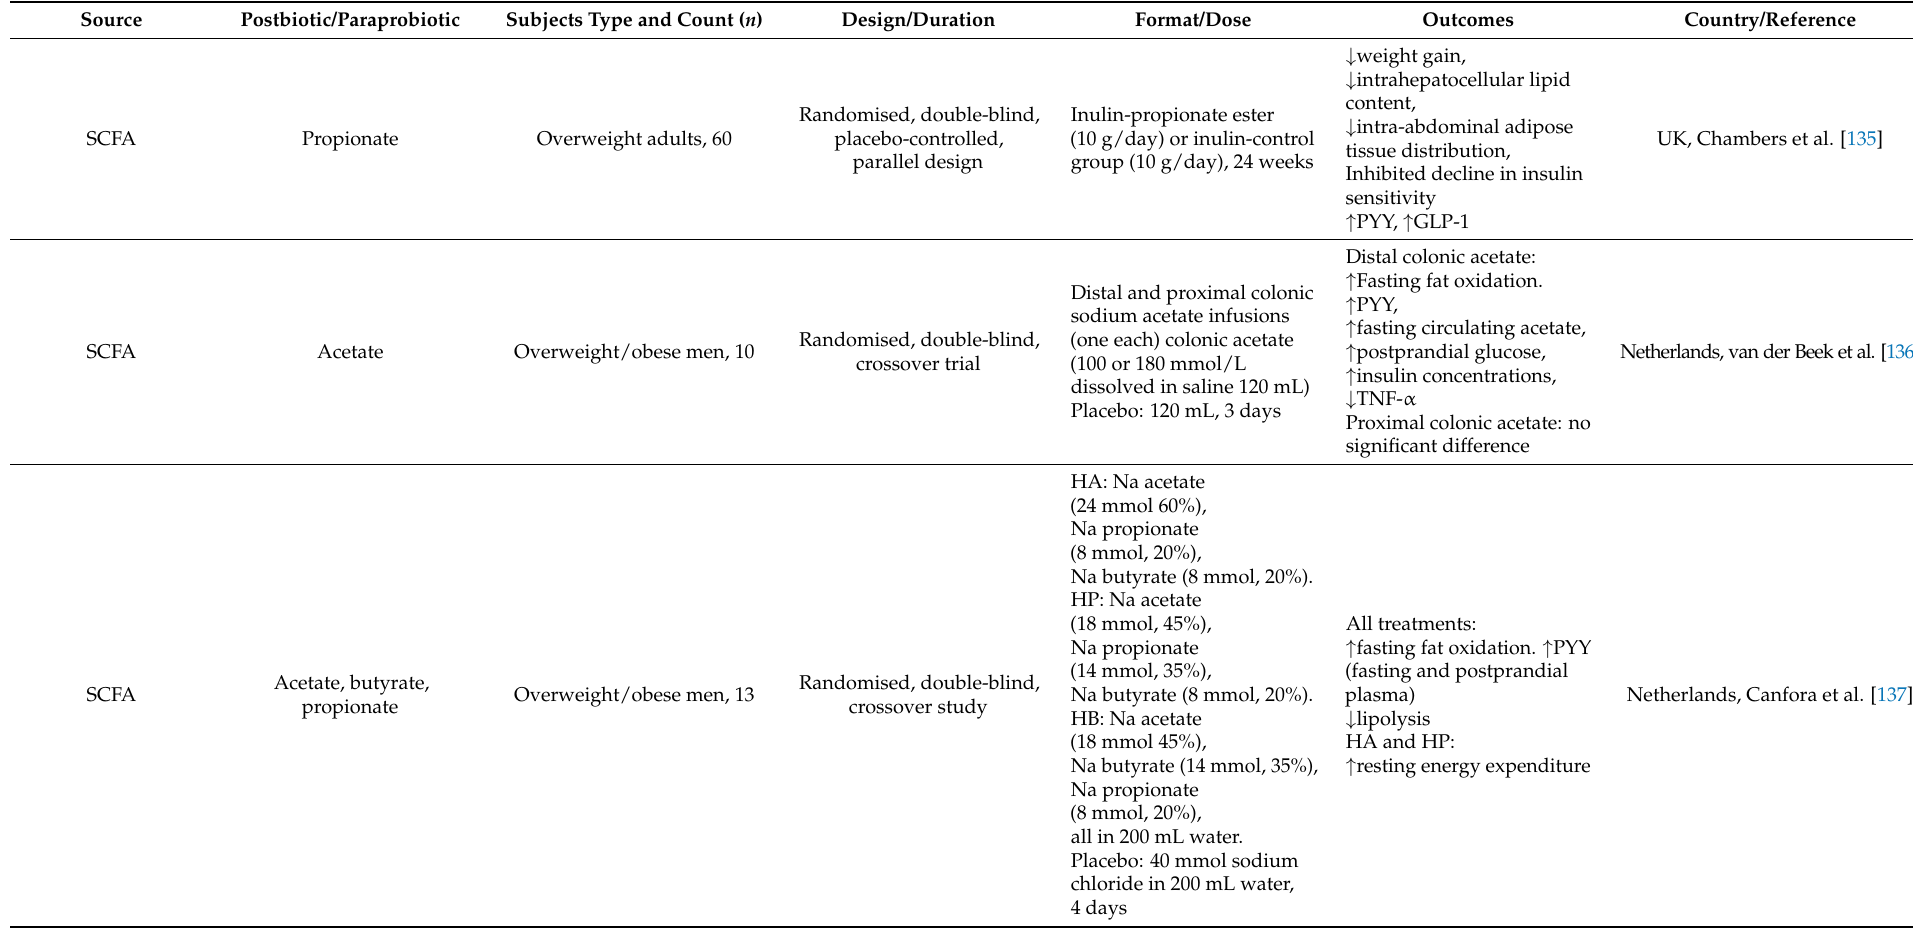
Table 2. Effects of postbiotics and paraprobiotics in obese and overweight